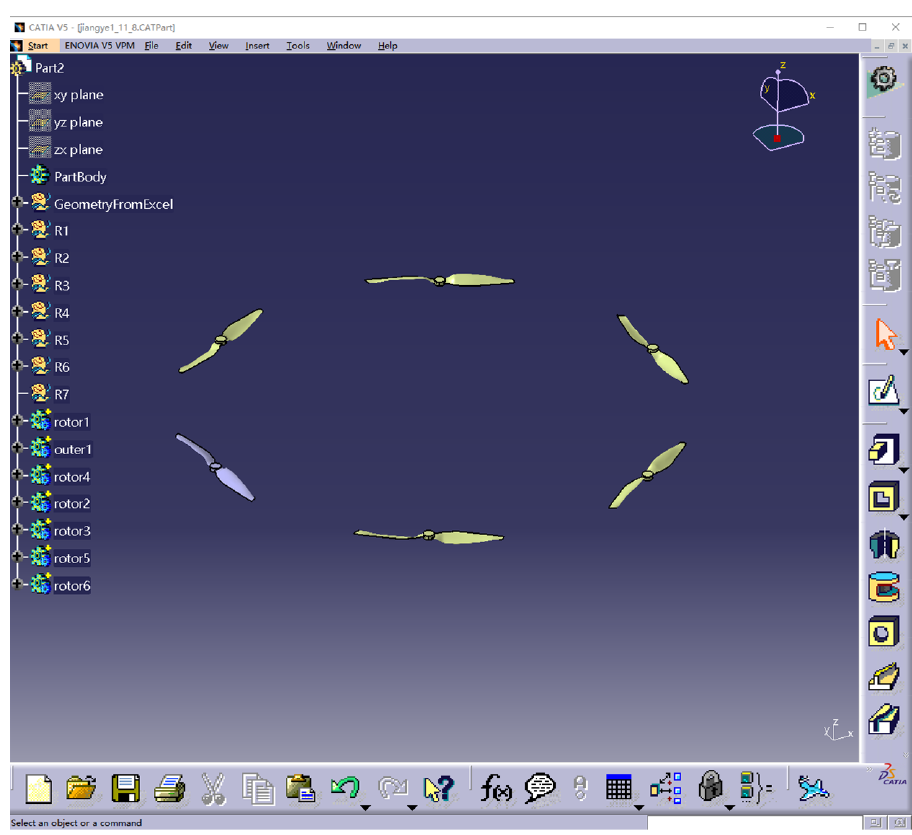
Figure 3. Physical model of six rotors for the Harvest-1 UAV. Moving fields containing six rotors for six cylinders with a bottom radius of 0.3 m and height of 0.05 m, were generated using CATIA software, as shown in Figure 4.